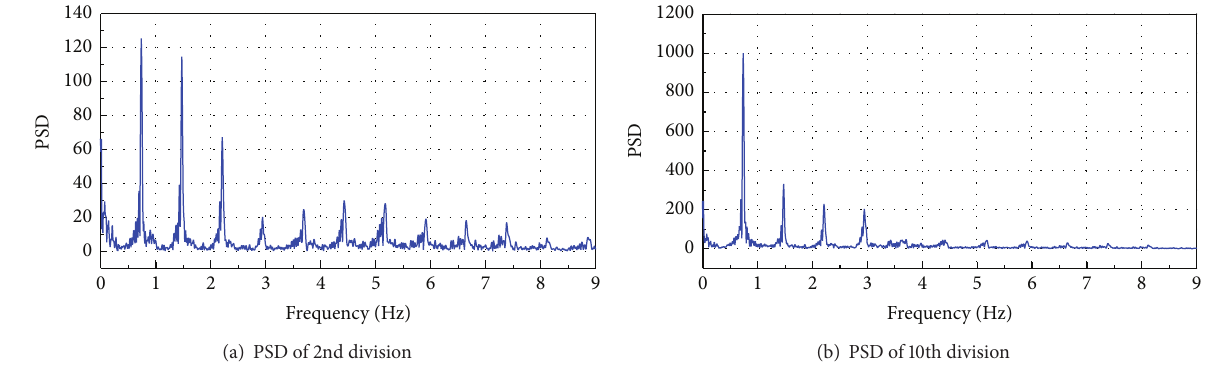
Figure 12: Power spectral density functions of VBM time histories (scheme 1).